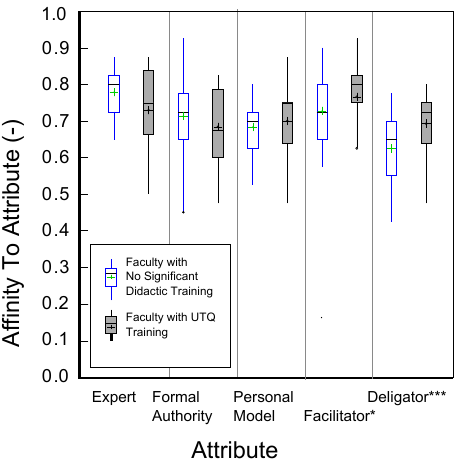
Fig. 2. Di ff erences of teaching-style between UTQ trained respondents and those who did not Fig. 2. Differences of teaching-style between UTQ trained respon- have significant didactic training. ∗ indicates p< 10%, ∗∗ p< 5% and ∗∗∗ p< 1%. Horizontal bar dents and those who did not have significant didactic training. ∗ indicates mean and the cross, the median. Boxes show 25th and 7th percentile. indicates p < 10%, ∗∗ p < 5% and ∗∗∗ p < 1%. Horizontal bar indicates mean and the cross, the median. Boxes show 25th and 7th